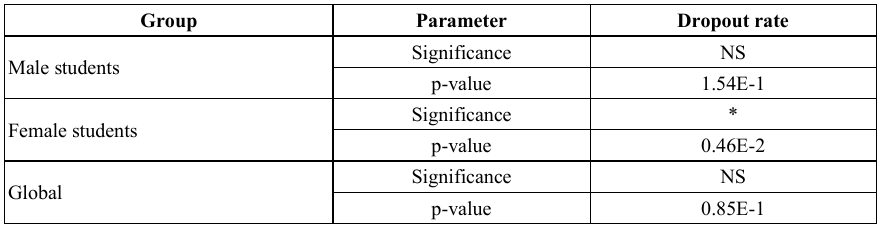
Table 9. Dropout rate comparison: gender gap evolution (2019-2020) Group Parameter Dropout rate Male students